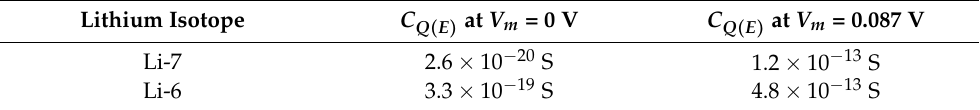
Table 8. The table shows that extracellular lithium isotopes can have a range of quantum conductance of single channel from the value at V m = 0 V to the value at V m = 0.087 V according to the setting values in graph (c) of Figure